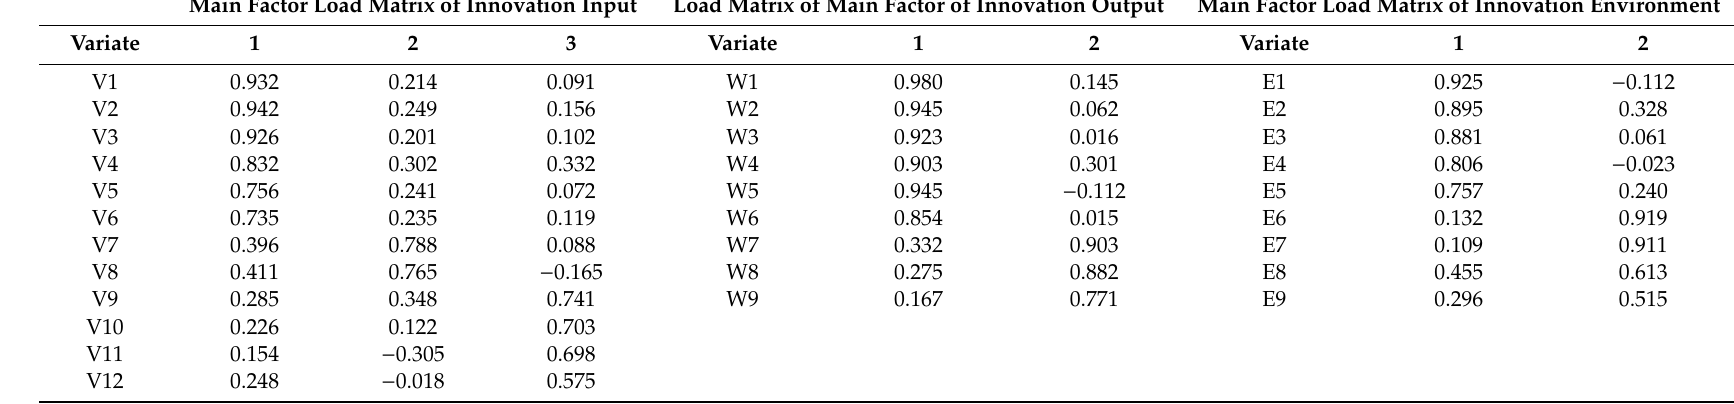
Table 3. Factor load matrix after